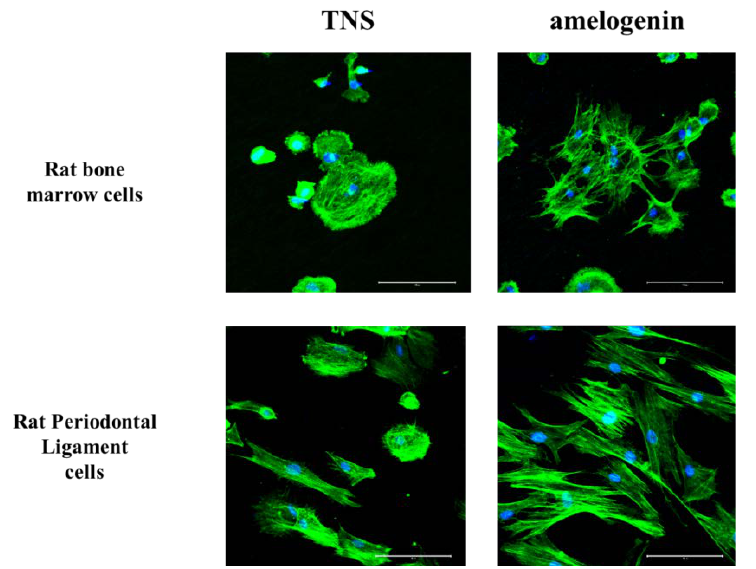
Figure 6. Morphology of rat bone marrow (RBM) cells and rat periodontal ligament cells in the control and test groups after culturing for 24 h. Actin filaments (green) were labeled with Alexa Fluor 488-phalloidin and nuclei (blue) were stained with 4′,6-diamidino-2-phenylindole (DAPI).